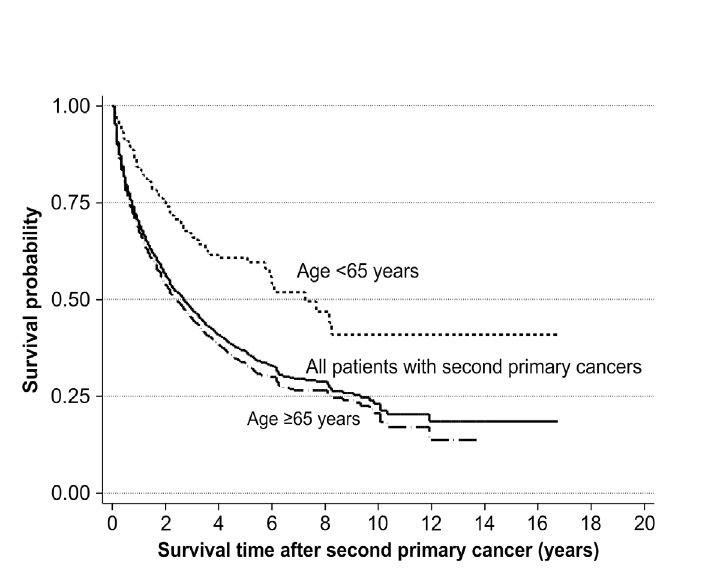
Fig 2. Kaplan-Meier curves showing survival after a second primary cancer.